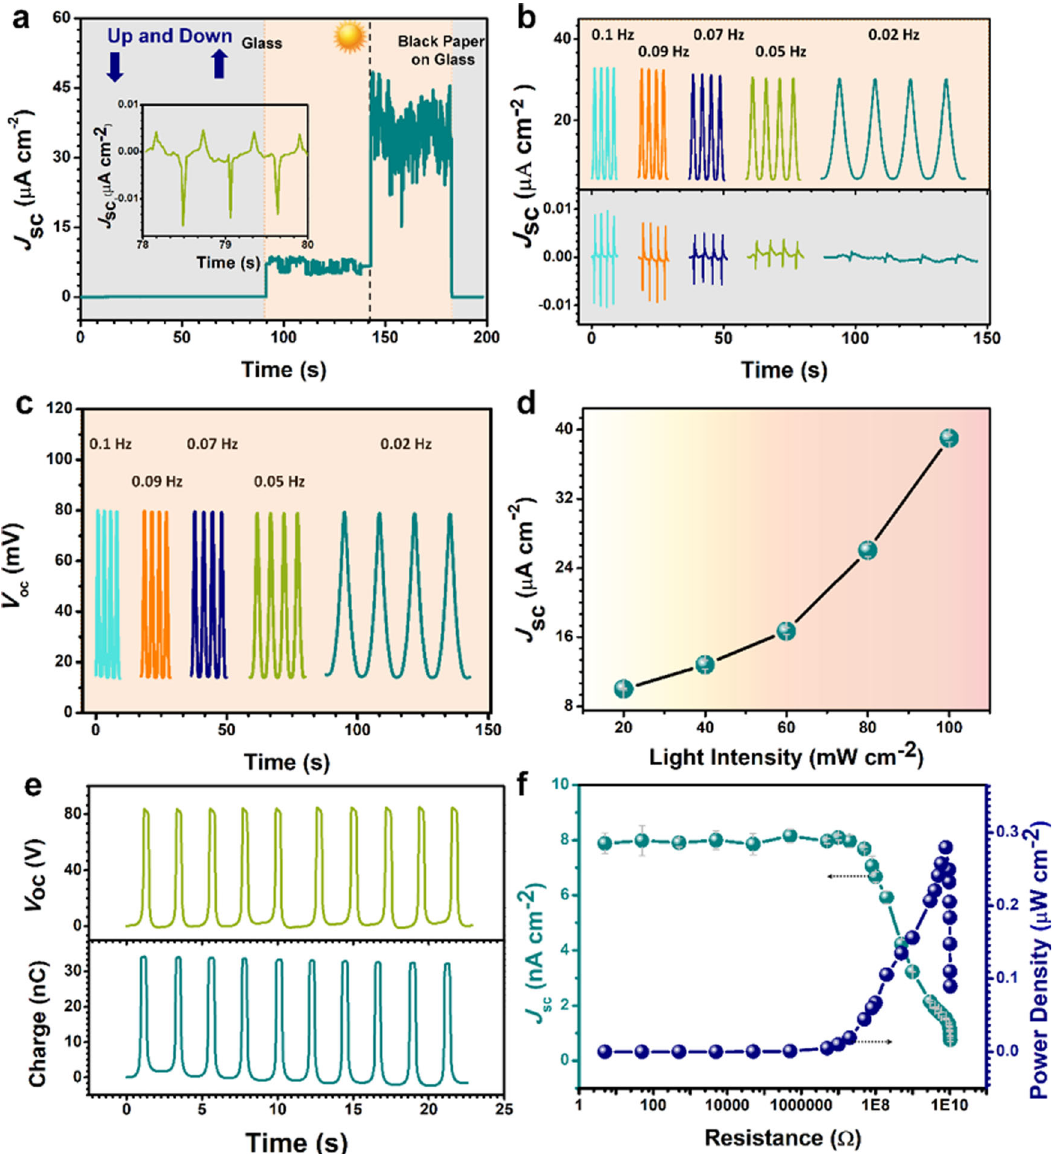
Fig. 4 Output performance of the shadow-tribo-effect nanogenerator (S-TENG). a Glass with or without black paper moved on it up and down above half of S-TENG. Inset is the details of the output performance from 78 s to 80 s. b In fl uence of the frequency of the moving stage up and down on the short- circuit current density ( J sc ) under dark and illumination conditions. c In fl uence of the moving stage up and down frequency on open-circuit voltage ( V oc ) under illumination conditions. d Dependence of light intensity on output of S-TENG. e The V oc and charge output of the S-TENG in a single-electrode TENG connection. f Output power density of the S-TENG in a single-electrode TENG connection with different load